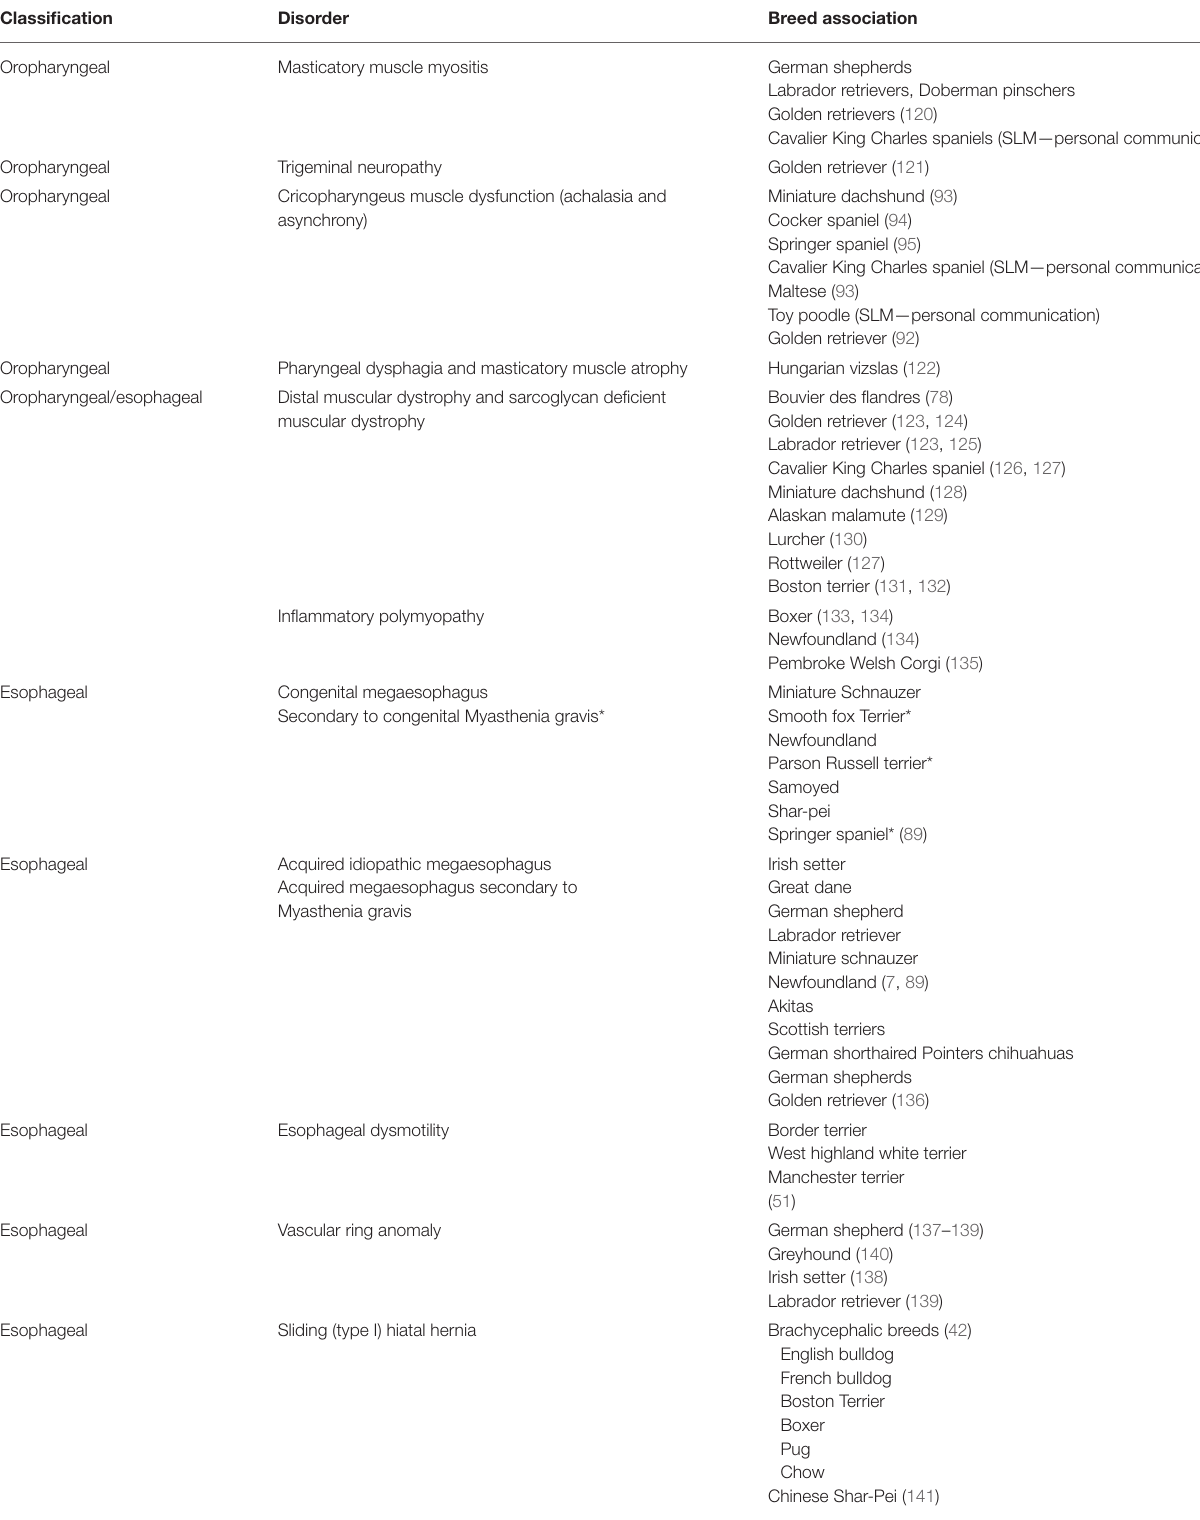
TABLE 1 | Breed associations of oropharyngeal and esophageal swallowing disorders in